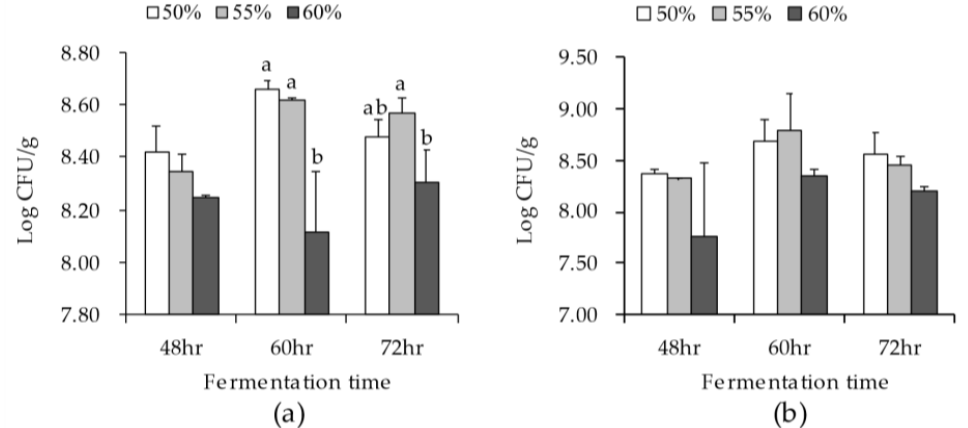
Figure 1. Effect of different initial moisture content on Lactobacillus species ( a ) and C. butyricum ( b ) growth in mixed SSF of okara and CM. Values are expressed as mean ± SD ( n = 3). Means of different fermentation during time treatment with different superscript letters are significantly different at p < 0.05.